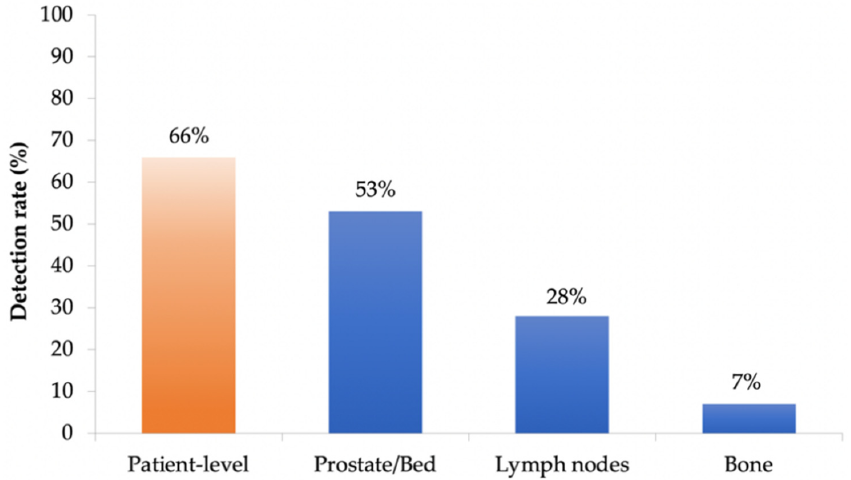
Figure 1. Per-patient and per-lesion detection rate of [ 18 F]Fluciclovine PET/CT. The mean PSA value at the time of the scan was 1.25 ng/mL (median: 0.92 ng/mL;